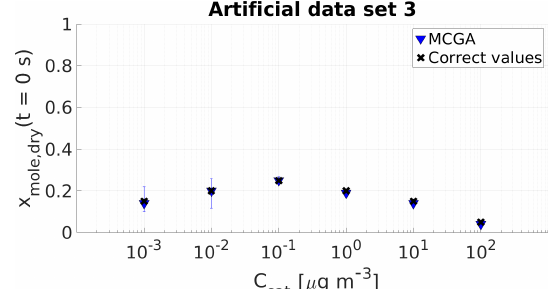
Figure 4. Parameter estimates for artificial data set 3; dry parti- cle mole fraction at the start of the evaporation of six model com- pounds with predefined saturation concentration were optimized to match the data. Blue triangles show the MCGA estimates and black crosses the correct values. The whiskers show the 10th and 90th percentiles of the estimated variable